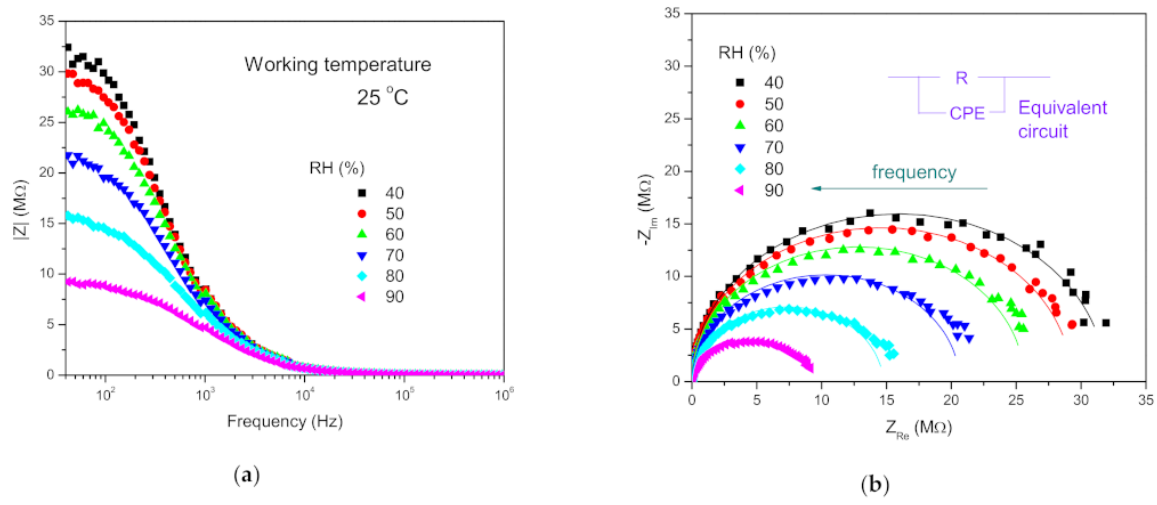
Figure 6. Impedance dependence on frequency ( a ) and complex impedance ( b ) measured (points) and fitted (line) using the equivalent circuit shown in the inset, for relative humidity RH 40-90% of NiMn 2 O 4 nanocrystalline fibers at the working temperature of 25 ◦